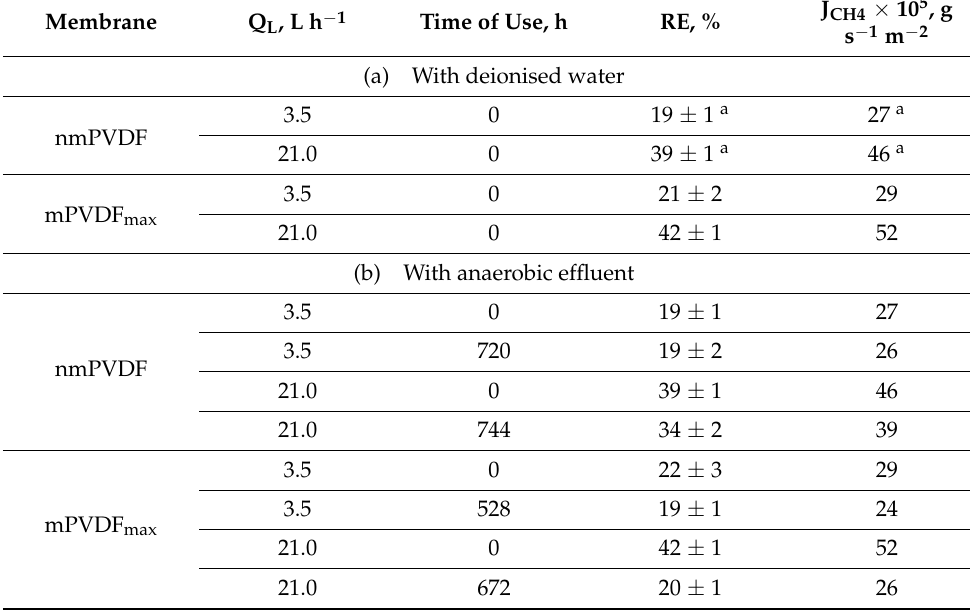
Table 3. Effect of the time of use on the dissolved CH 4 removal efficiency (RE) and CH 4 flux (J CH4 ) in degassing tests (at 5 h of time on stream) with non-modified PVDF (nmPVDF) and modified PVDF (mPVDF max ) at different liquid flow rates (Q L ) of distilled water and anaerobic reactor effluent. J CH4 × 10 5 , g Membrane Q L , L h − 1 Time of Use, h RE, % s − 1 m − 2 (a) With deionised water 3.5 0 19 ± 1 nmPVDF